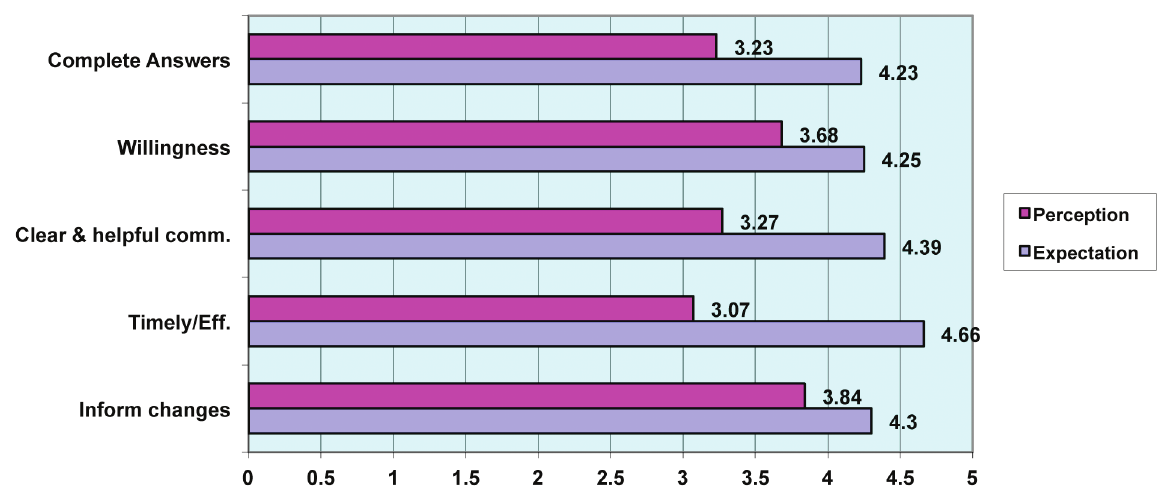
Figure 3: Responsiveness: Expectations versus perceptions